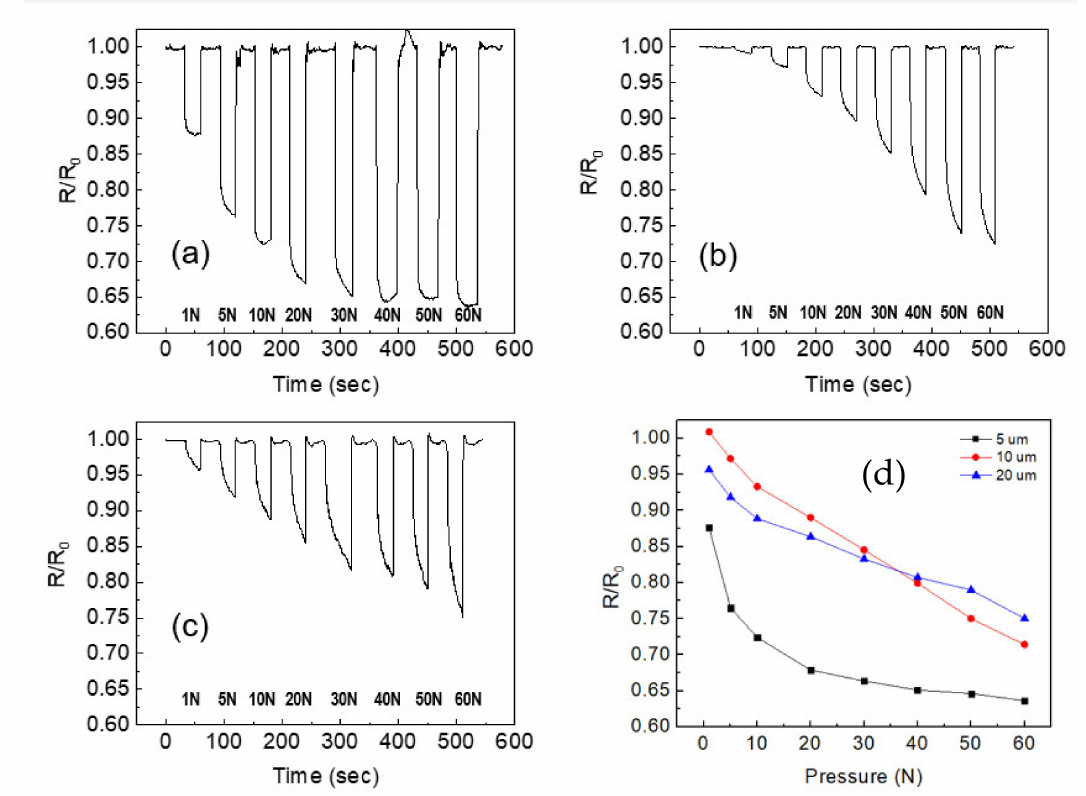
Figure 4B. Sensitivity of the fabricated composite sensors. Change in R/R0 versus time and applied force: ( a ) TPU-(MWCNT-PMMA) (5 µ m), ( b ) TPU-(MWCNT-PMMA) (10 µ m), and ( c ) TPU-(MWCNT- PMMA) (20 µ m). ( d ) R/R O vs. pressure curve for TPU-(MWCNT-PMMA) (5, 10 and 20 µ